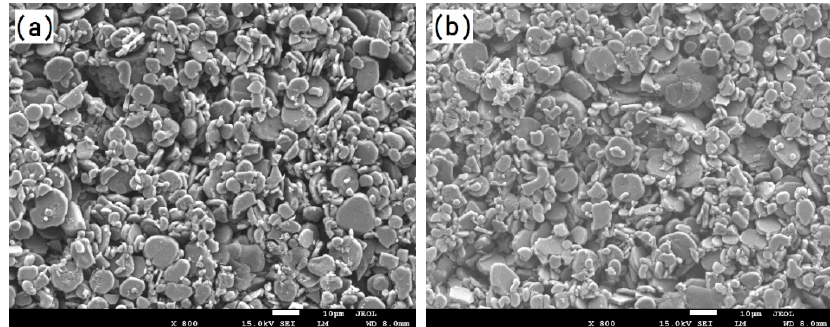
Figure 9. Microstructure of the fused alumina facecoats with added ( a ) 2 wt.% h-BN and ( b ) 5 wt.% h-BN after fired at 850 °C in air for 2 h.